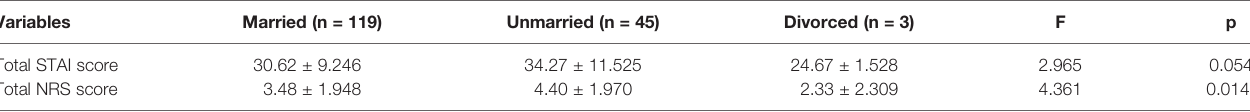
TABLE 2 | The effect of different marital status on women ’ s NRS score and STAI score (ANOVA). Variables Married (n =